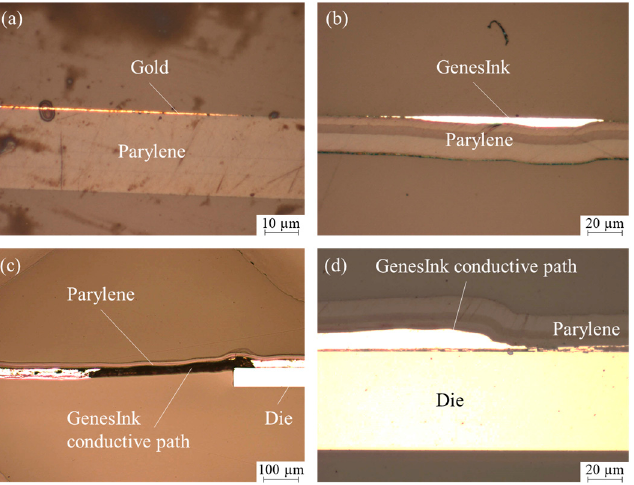
Figure 10. Light microscopic images of cross-sections: ( a ) Sputtered and transferred gold on Parylene, ( b ) printed GenesInk, ( c ) transferred silicon die, including printed conductive path, and ( d ) printed contact pad on transferred silicon die.